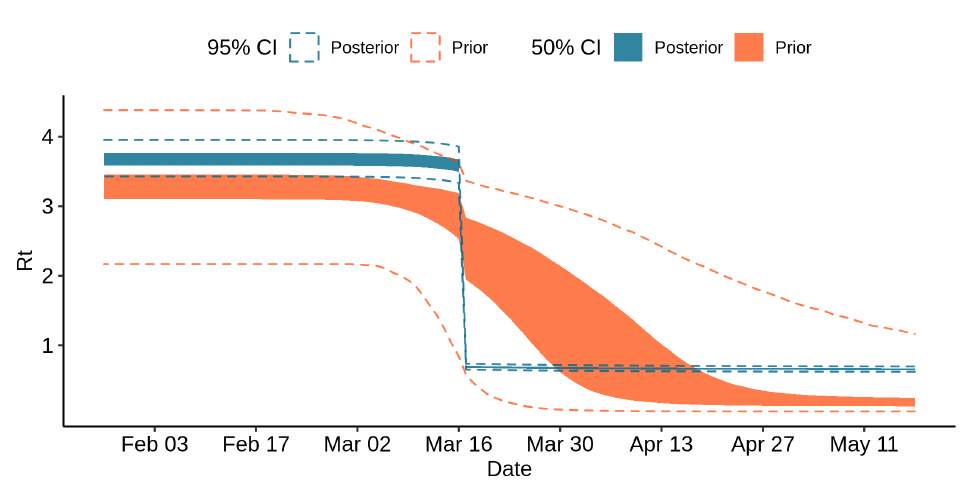
Figure 5 – Prior and posterior samples of R t in region